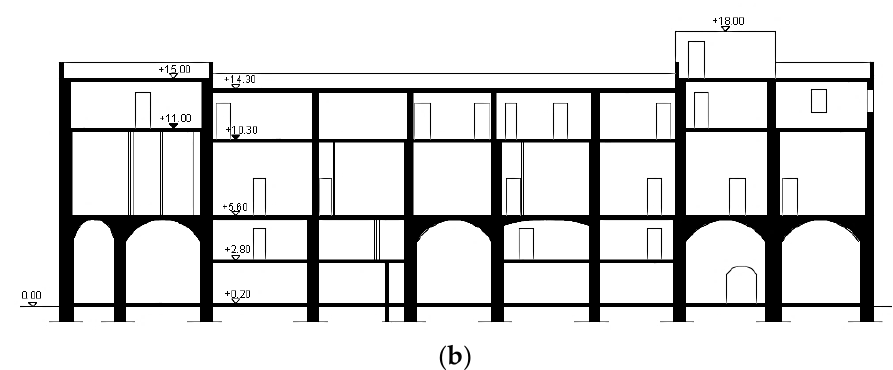
Figure 2. The masonry aggregate geometric configuration: ( a ) plan layout and ( b ) section A-A’ (measurements in meters).